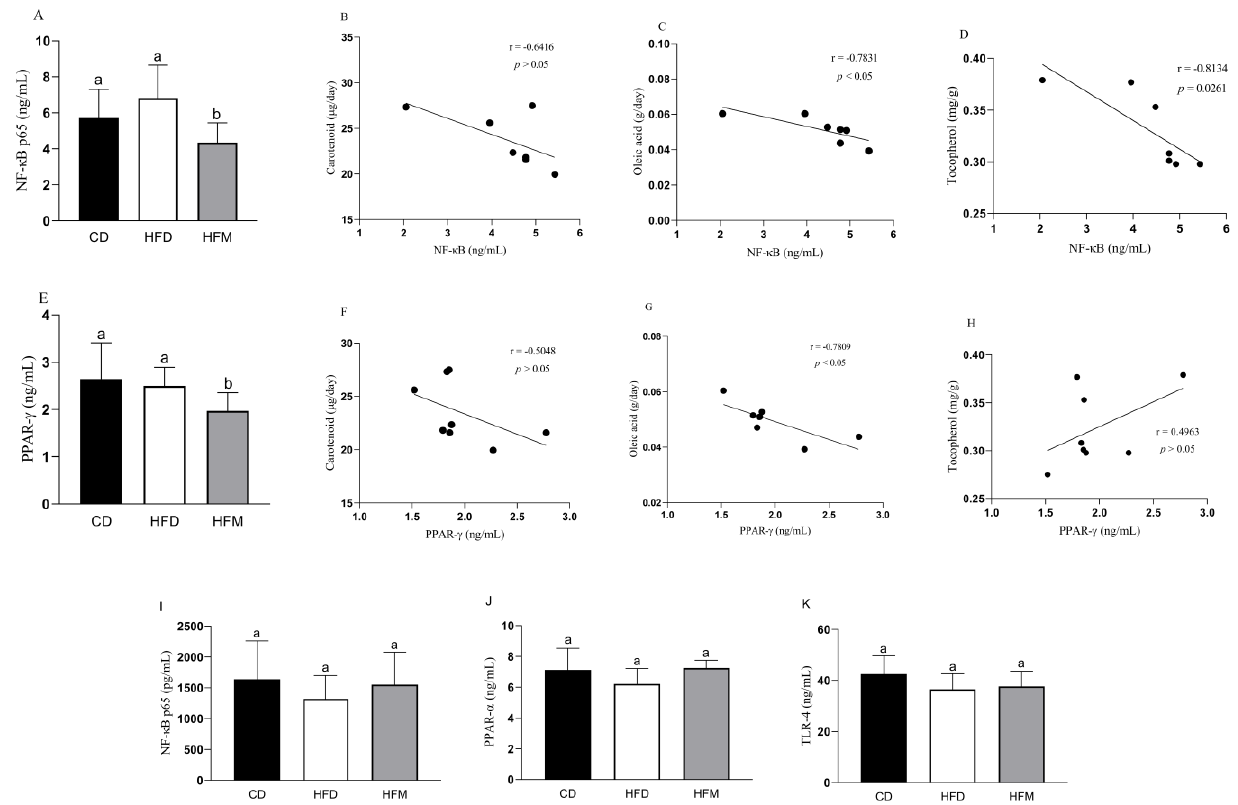
Figure 2. Levels of proteins in the adipose tissue ( A – H ) and liver ( I – K ) of mice after consuming the experimental diets for 8 weeks, and correlation with carotenoid, oleic acid, and tocopherol intakes. Data are expressed as mean ± standard deviation ( n = 8). Different letters indicate a statistical differ-